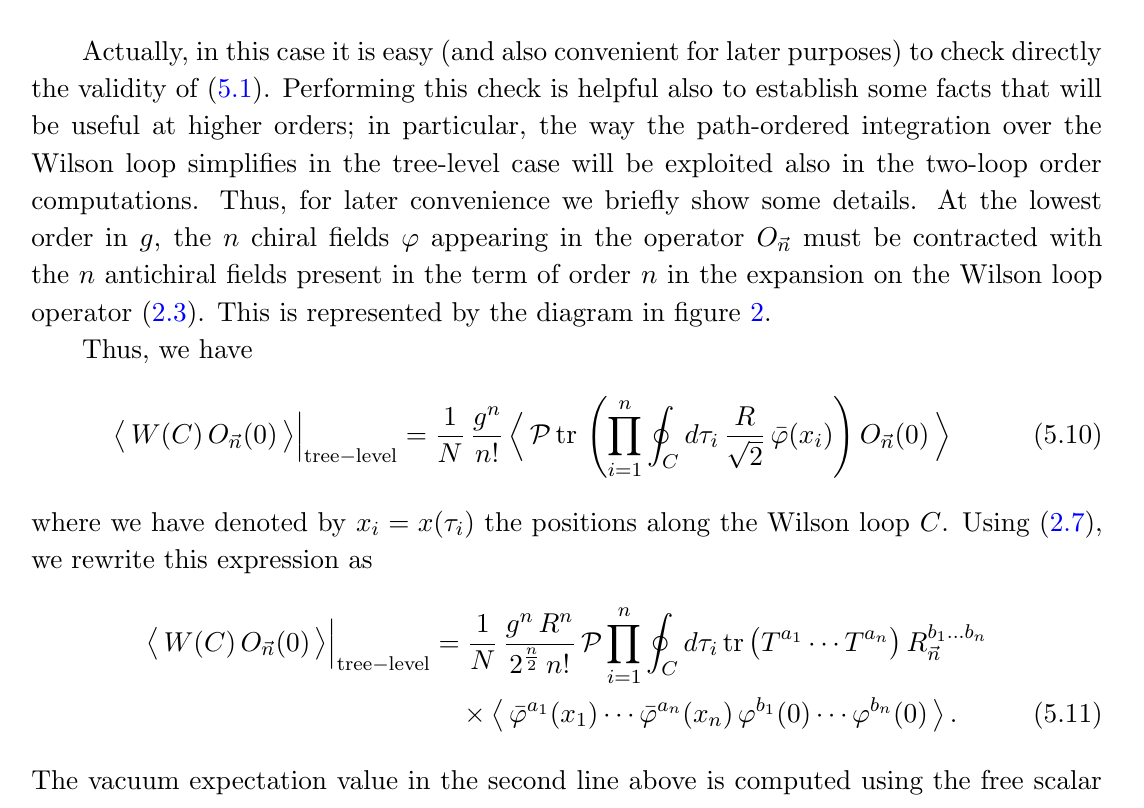
Figure 2 . At the lowest perturbative order, the operator O ~n ( x ) is connected to the Wilson loop by n scalar propagators. Exploiting conformal invariance, we can place the operator in the origin, i.e. in the center of the Wilson loop. Nevertheless, in this and in the following pictures we will continue to place it outside the loop to avoid graphical